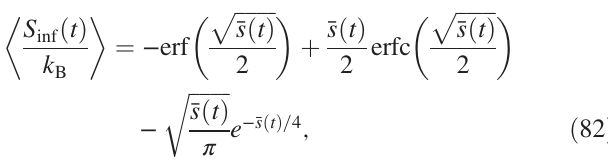
(yellow B k T , 0 ¼ B env